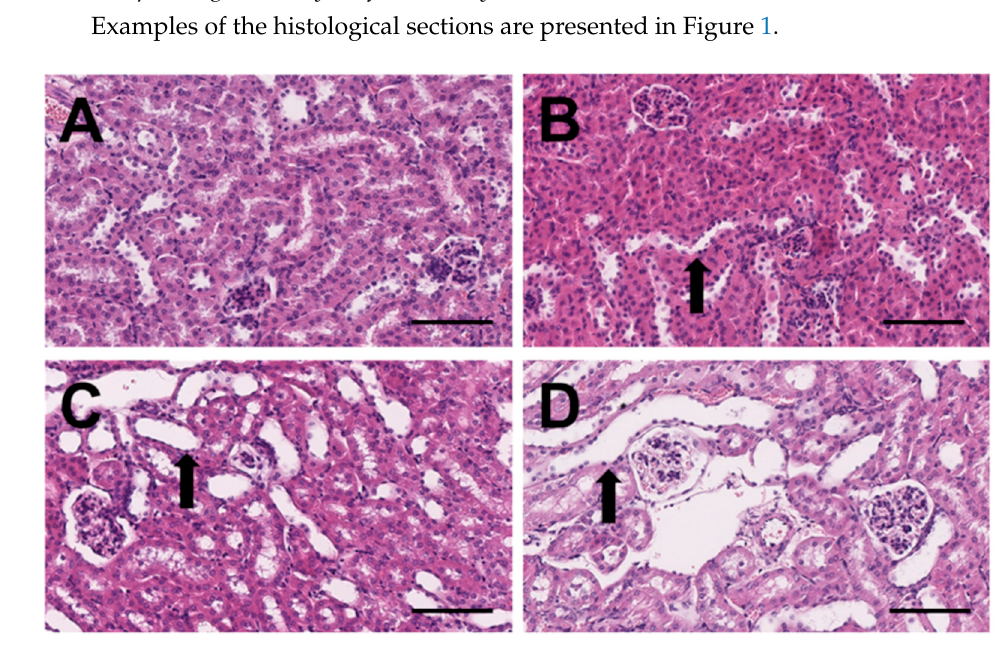
Figure 1. Microscopic images of the kidneys of individual mice in group 1 ( A ), group 2 ( B ), group 3 ( C ), and group 4 ( D ). Tubules are increasingly dilatated in animals of groups 2, 3, and 4 (black arrows). (HE, scale bars: 100 μ m).